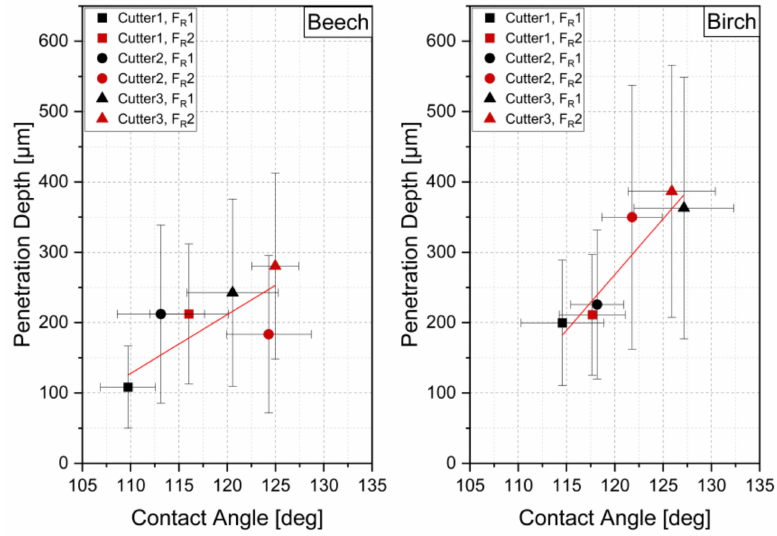
Figure 15. Interactions between penetration depth and contact angle for different cutting combina- tions; the red line shows trendline, and error bars show standard deviation in x (contact angle) and y (penetration depth)